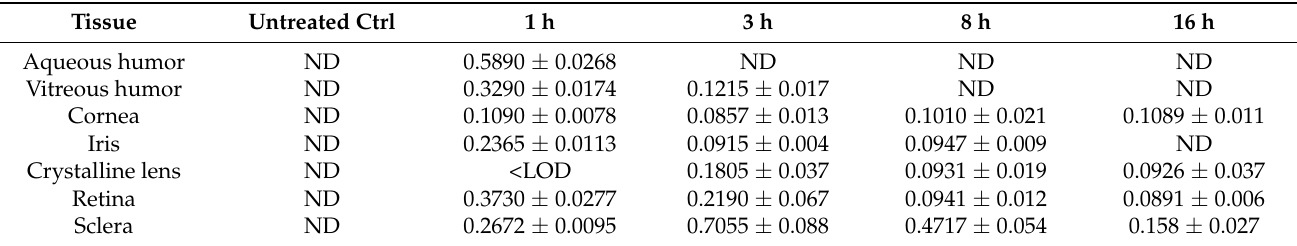
Table 3. Quantitative determination of ODAF in samples. Results are expressed as ng of ODAF for mg of extracted tissue ± standard deviation (SD). (LOD: 0.063 ng/mL; LOQ: 0.210 ng/mL).